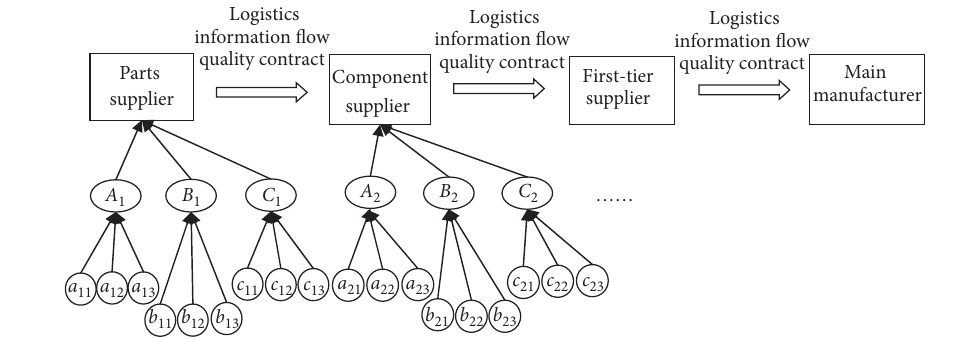
Figure 5: Supply chain quality risk propagation process.